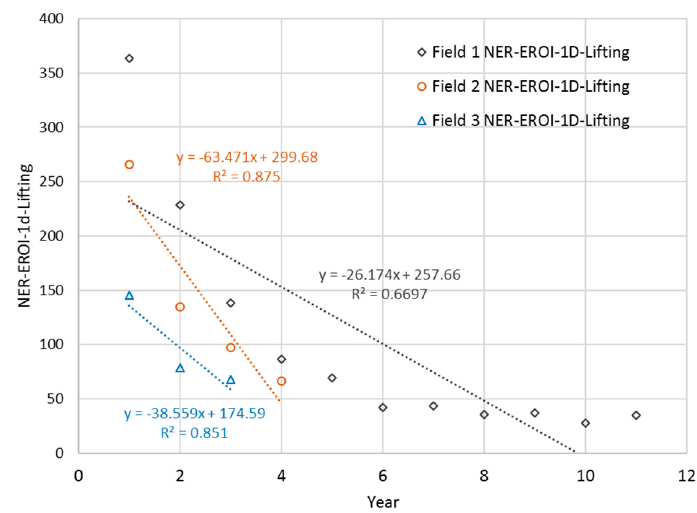
Figure 4. NER-EROI-1d Lifting time series for three small fields.